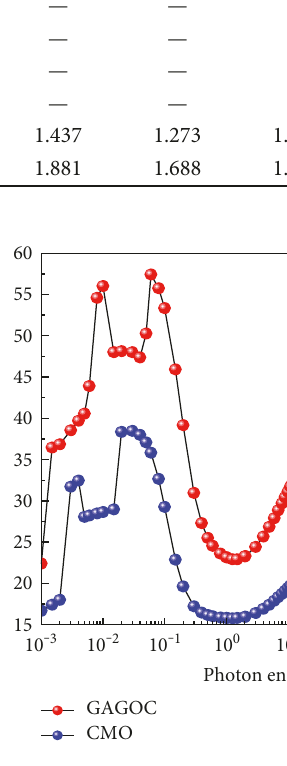
) as a function e ff